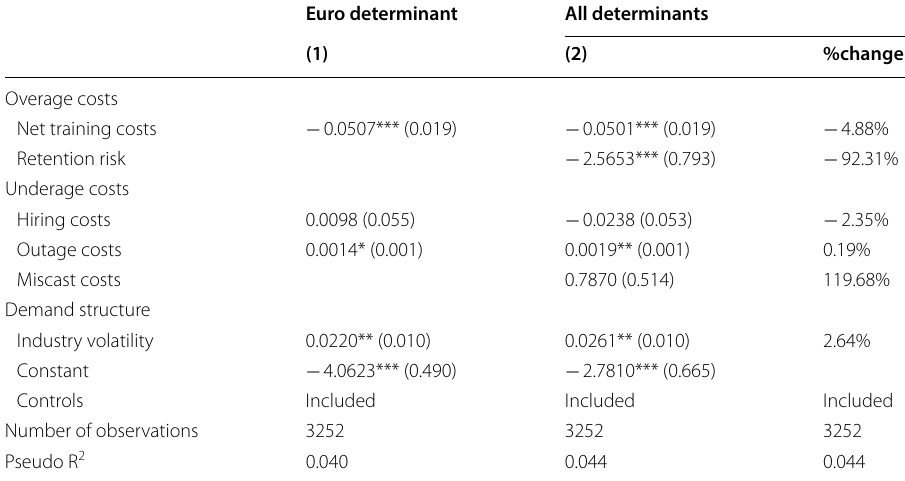
Table reports marginal effects of a negative binomial regression; all costs are in 10,000 Euros per person; %‑change calculated as (incidence‑rate